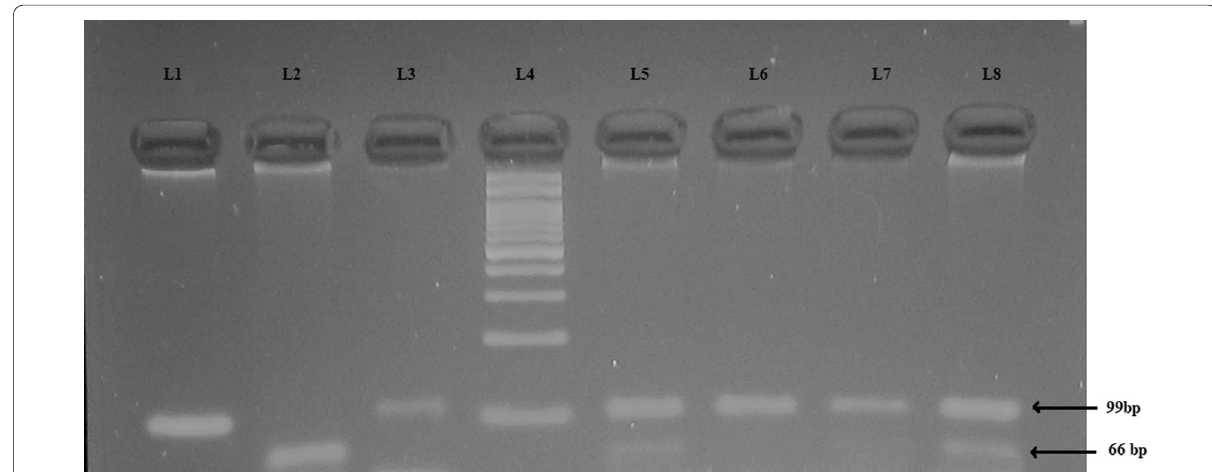
Fig. 1 The 3% agarose gel picture of AlwI digested products of PON1 rs664 gene. Lane 1 shows undigested PCR product corresponding to a band of 99 bp, lanes 5 and 8 show QR genotype corresponding to three bands sizes of 99 bp, 66 bp and 33 bp, lanes 3, 6 and 7 show the QQ genotype corresponding to one bands of 99 bp and lane 2 shows RR genotype corresponding to two bands of 66 bp, 33 bp, whereas lane 4 shows 100 bp ladder